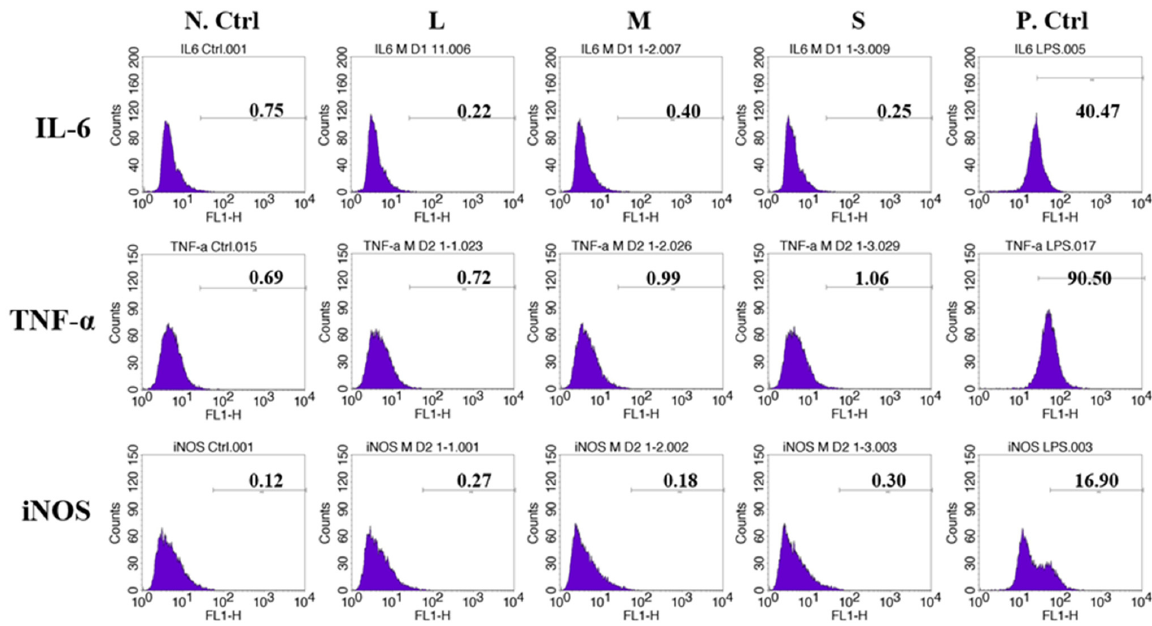
Figure 5. FACS histograms for the expression of inflammatory cytokines, IL ‐ 6, TNF ‐α , and iNOS, in RAW 264.7 cells treated with 3 different types of highly porous microspheres (L, M, and S) for 24 h. The cells without microspheres and LPS treatment were used as a negative control (N. Ctrl), and those treated with LPS (1 μ g/mL) were used as a positive control (P. Ctrl).